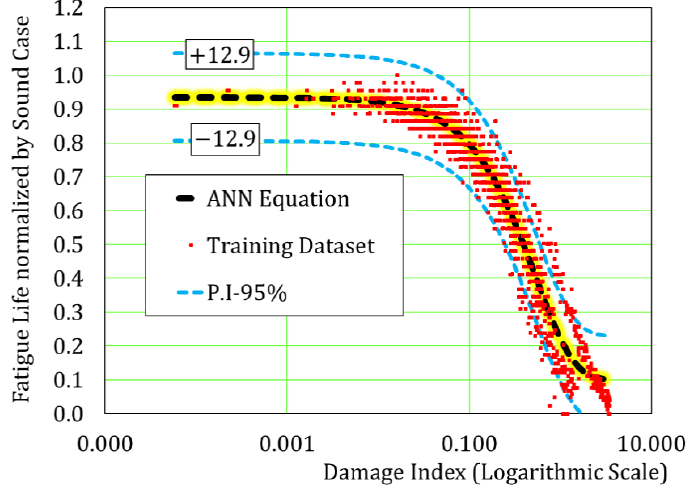
Figure 18. Relationship between damage index and the normalized remaining fatigue life.